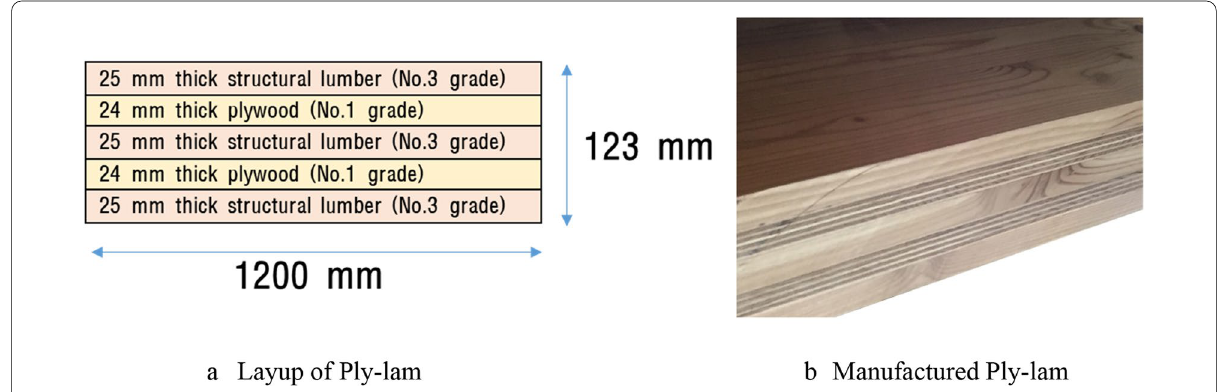
Fig. 4 Layup and a picture of the manufactured Ply‑lam